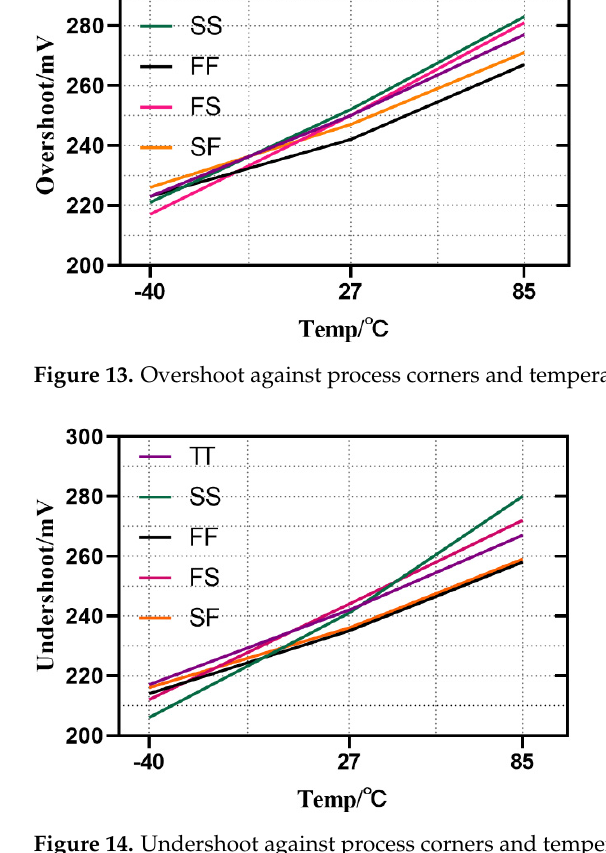
Figure 14. Undershoot against process corners and temperature variations. For the layout of the design, we used a 0.18 μ m standard CMOS process. Figure 15 shows the layout of this design, with an active area of approximately 0.0235 mm 2 (156.8 μ m × 149.8 μ m).